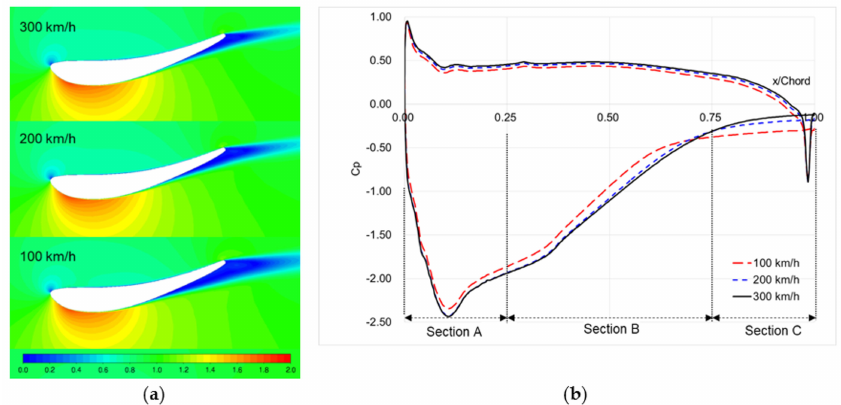
Figure 6. Comparison of the flow fields around the spoiler at various driving speeds: ( a ) Normalized velocity magnitude ( b ) Surface pressure distributions: Section A: Suction peak and pressure recovery section (before maximum thickness); Section B: Pressure recovery section; Section C: Flow separation